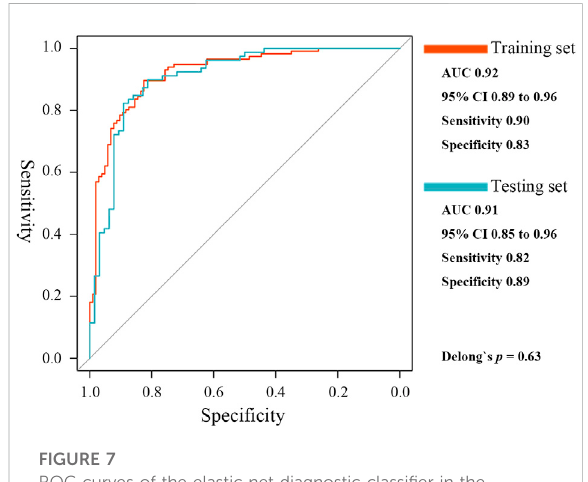
FIGURE 7 ROC curves of the elastic net diagnostic classi fi er in the training and testing